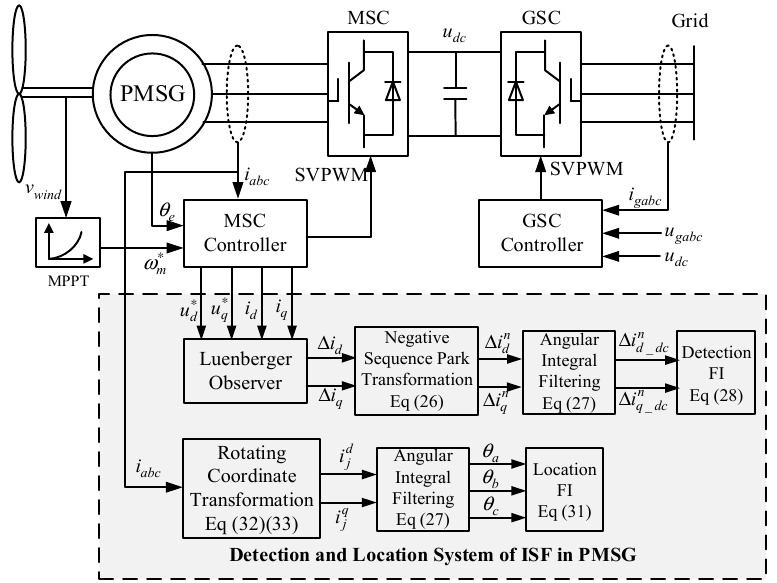
Figure 5. Overall process of ISF detection and location in PMSG.